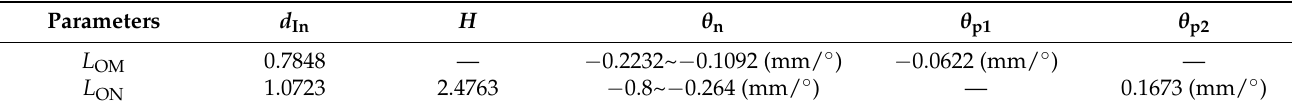
Table 3. Sensitivity of L OM and L ON to each parameter.